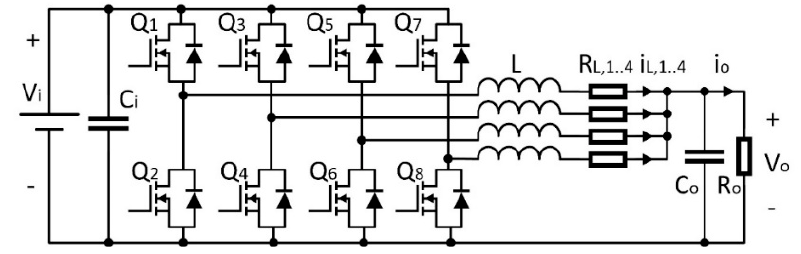
Figure 1. Multiphase synchronous DC-DC converter.